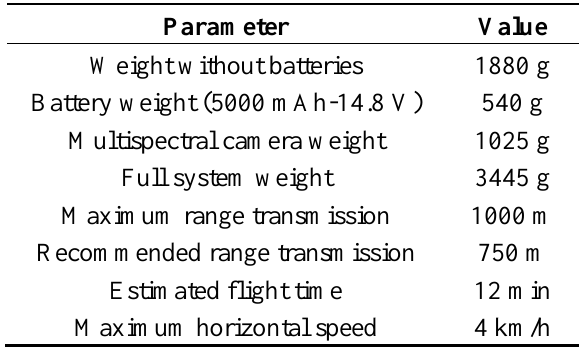
Table 3. Unmanned aerial systems (UAS)